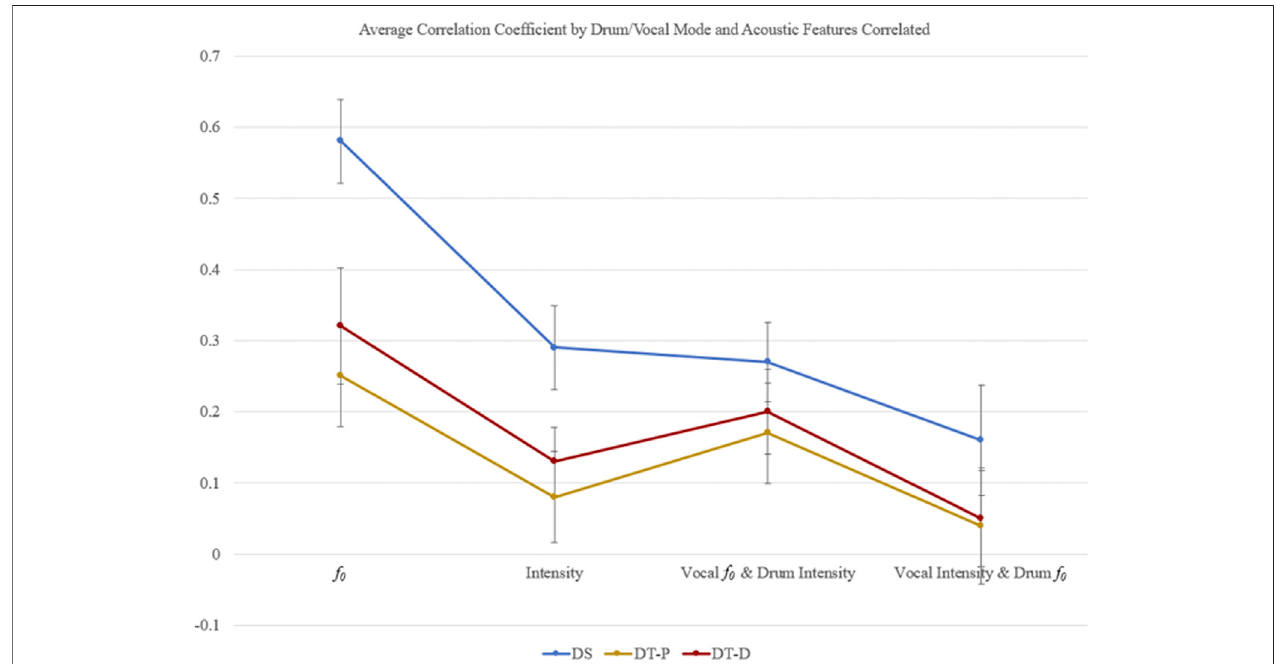
FIGURE 10 | Average correlation coef fi cients for all songs broken down by drum/vocal mode (DS, DT-P, and DT-D) and acoustic features used to obtain the correlation (drum f 0 /vocal f 0 , drum intensity/vocal intensity, drum intensity/vocal f 0 , and drum f 0 /vocal intensity). The signi fi cant difference of DS compared to both DT-P andDTDisapparent,asisthelargeeffectof f 0 / f 0 correlations,small-to-mediumeffectofintensity/intensityanddrumintensity/vocal f 0 ,andtheinsigni fi canteffectofdrum f 0 /vocal intensity. Error bars are ± 2